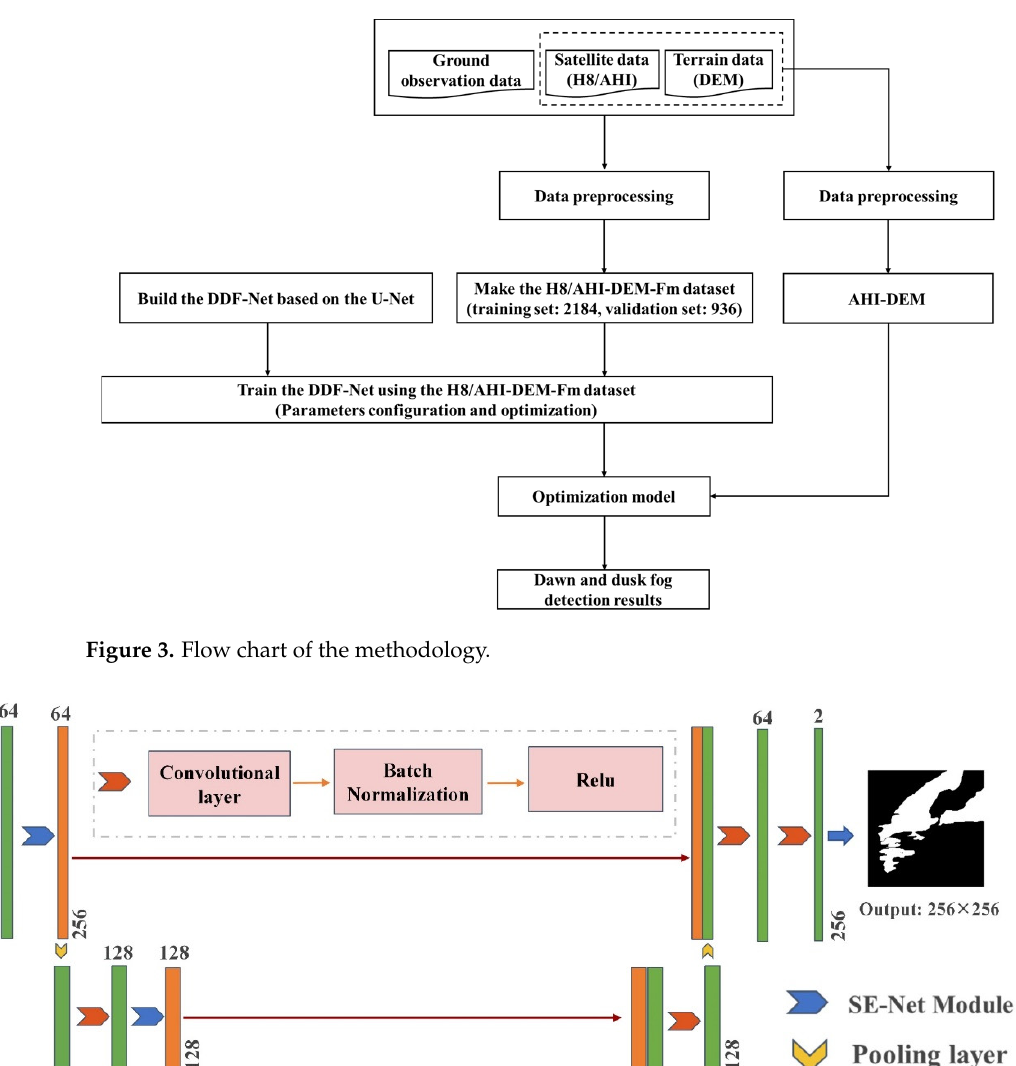
Figure 5. The process of making the H8/AHI-DEM-Fm dataset. (1) Building the AHI-DEM dataset at dawn and dusk. The remote sensing images including dawn and dusk are screened according to the SZA. Meanwhile, band clipping and sea-land mask clipping are performed. The DEM is